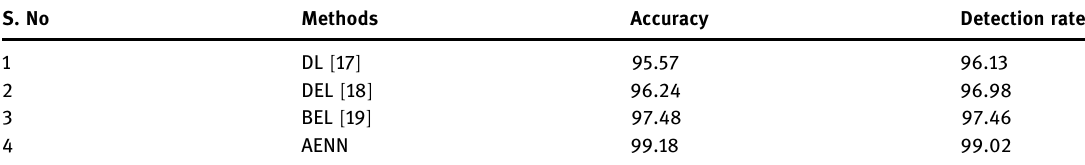
Table 3: Attack detection rate S.